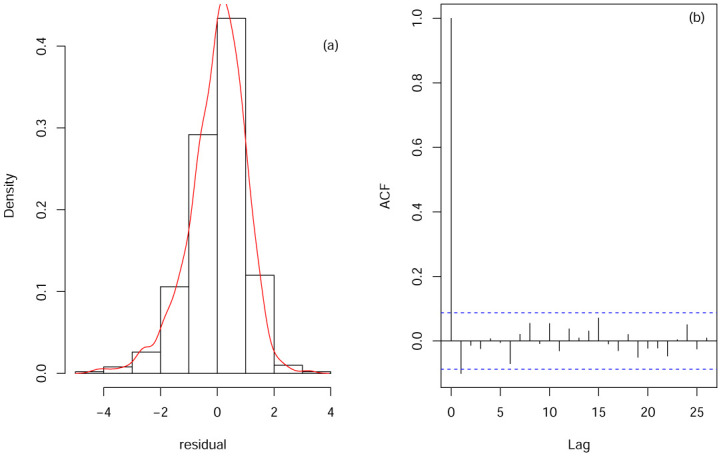
Residual histogram (a) and AFC (b) plot.